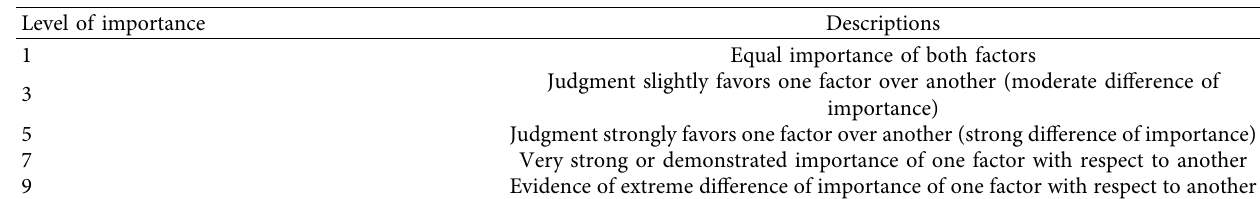
Table 2: Fundamental scales of absolute numbers (“Saaty scale”), adapted from Saaty [53]. Level of